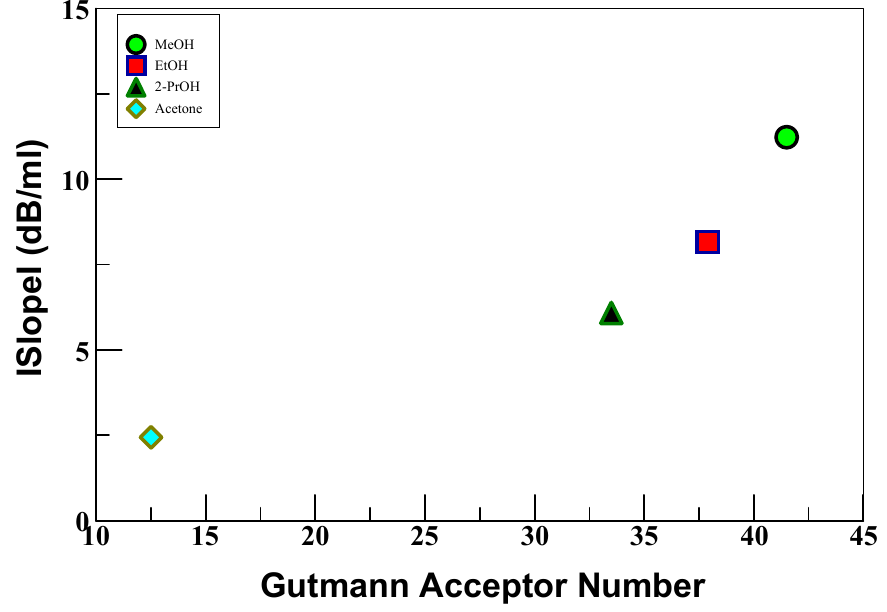
Figure 9. The relationship between the slope of the analyte volume dependence of insertion loss and the Gutmann Acceptor (AN). AN is a measure of hydrogen bond acidity, and the linear relationship suggests that the analyte molecules and/or the oxidation products form hydrogen bonds within the HKUST-1 structure.